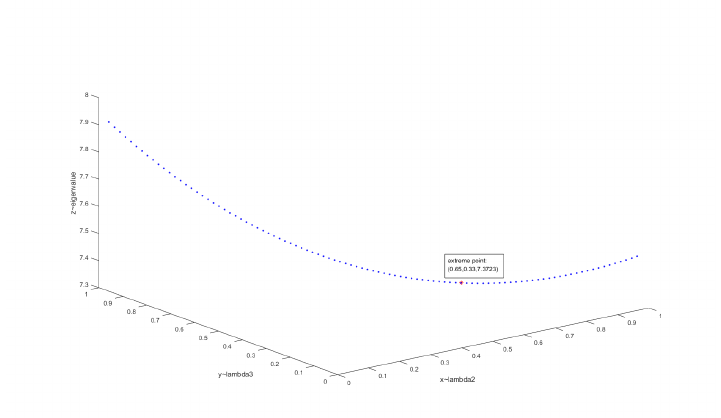
Figure 7. Eigenvalue trend of two matrices’s convex combination.